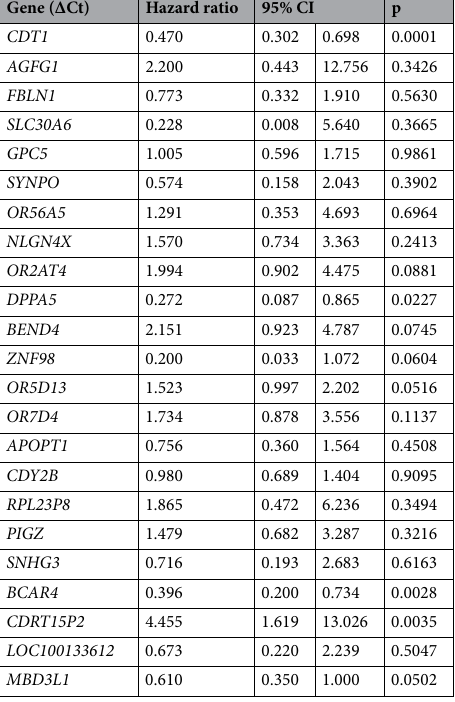
Table 3. Genes affecting the presence or absence of the postoperative recurrence and time to postoperative recurrence in patients with hepatocellular carcinoma in Cohort 3 by Cox multivariate proportional hazards regression model (n = 62). The mRNA expression of each gene in 62 cases with noncancerous frozen liver samples was quantified using RT-qPCR . Data were analyzed using the Cox multivariate proportional hazards regression